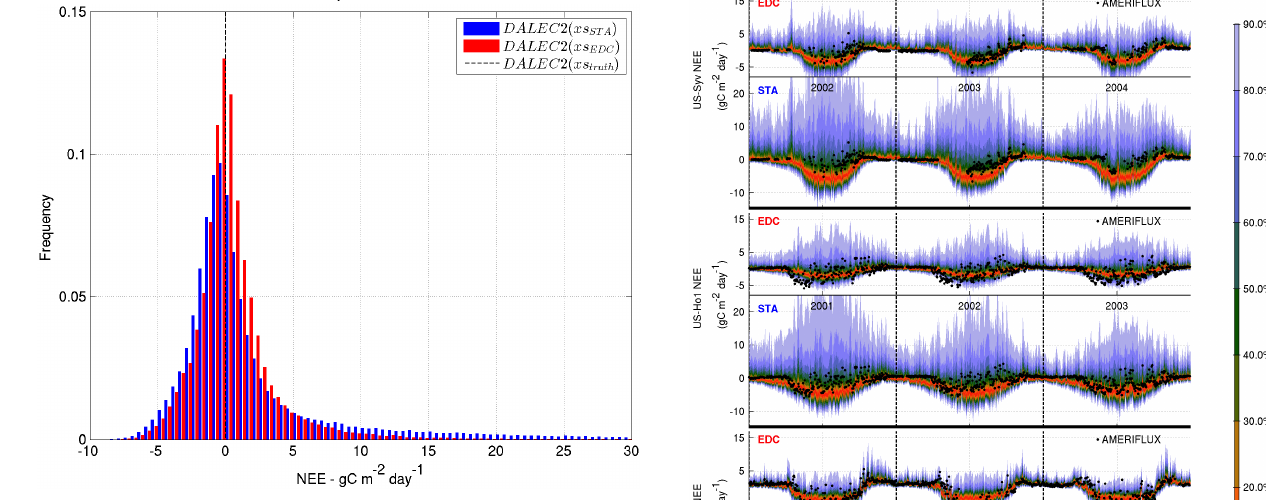
Figure 3. Three-year mean DALEC2 net ecosystem exchange (NEE) biases (relative to synthetic truth) aggregated across 40 syn- thetic experiments at 0.5gCm − 2 d − 1 intervals. The bias frequen- cies are shown for DALEC2( xs STA ) (standard sampling, blue) and DALEC2( xs EDC ) (EDC sampling, red) relative to the synthetic truth DALEC2( s ) (black dashed line).